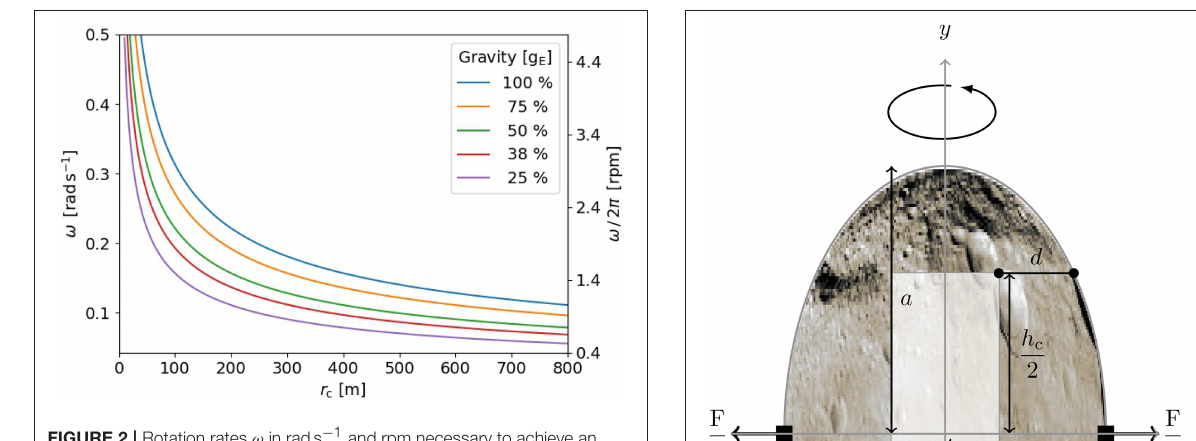
FIGURE 2 | Rotation rates ω in rads − 1 and rpm necessary to achieve an artificial gravity of g c on the lateral surface of a cylinder with radius r c .